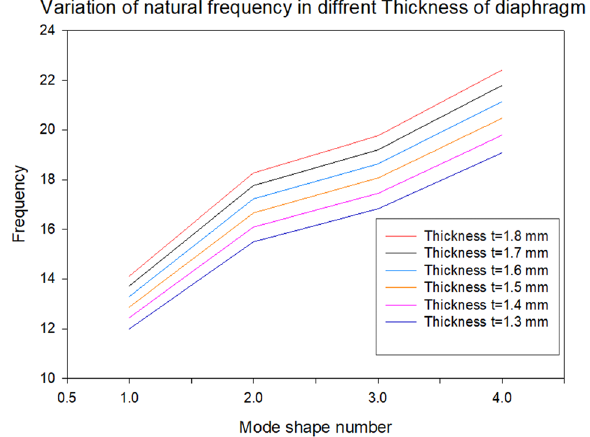
Fig. 29 The variation of natural frequency at different modes and different thicknesses of the